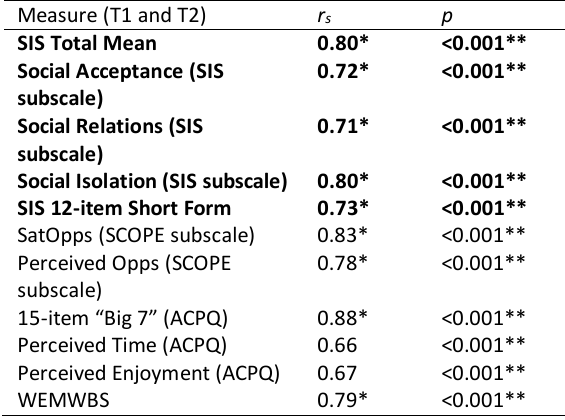
Table 4. Test-retest reliability assessment for each measure at times 1 and